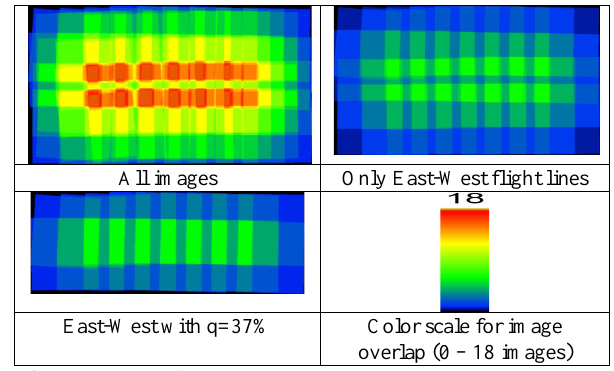
Fig. 10 : overlap of images, DMCII 140 with 9cm GSD The block adjustments with reduced image overlap (double and single blocks) have a smaller number of images per object point as it can be seen in figure 10. In the case of all images object points are located in up to 18 images, in the case of only the EAST-West flight lines in up to 9 images and in the case of the single block in up to 6 images. Corresponding to this lower object point accuracy is expected in the case of a reduced image overlap. This also can be seen, but the reduction of the accuracy is below the expectation.